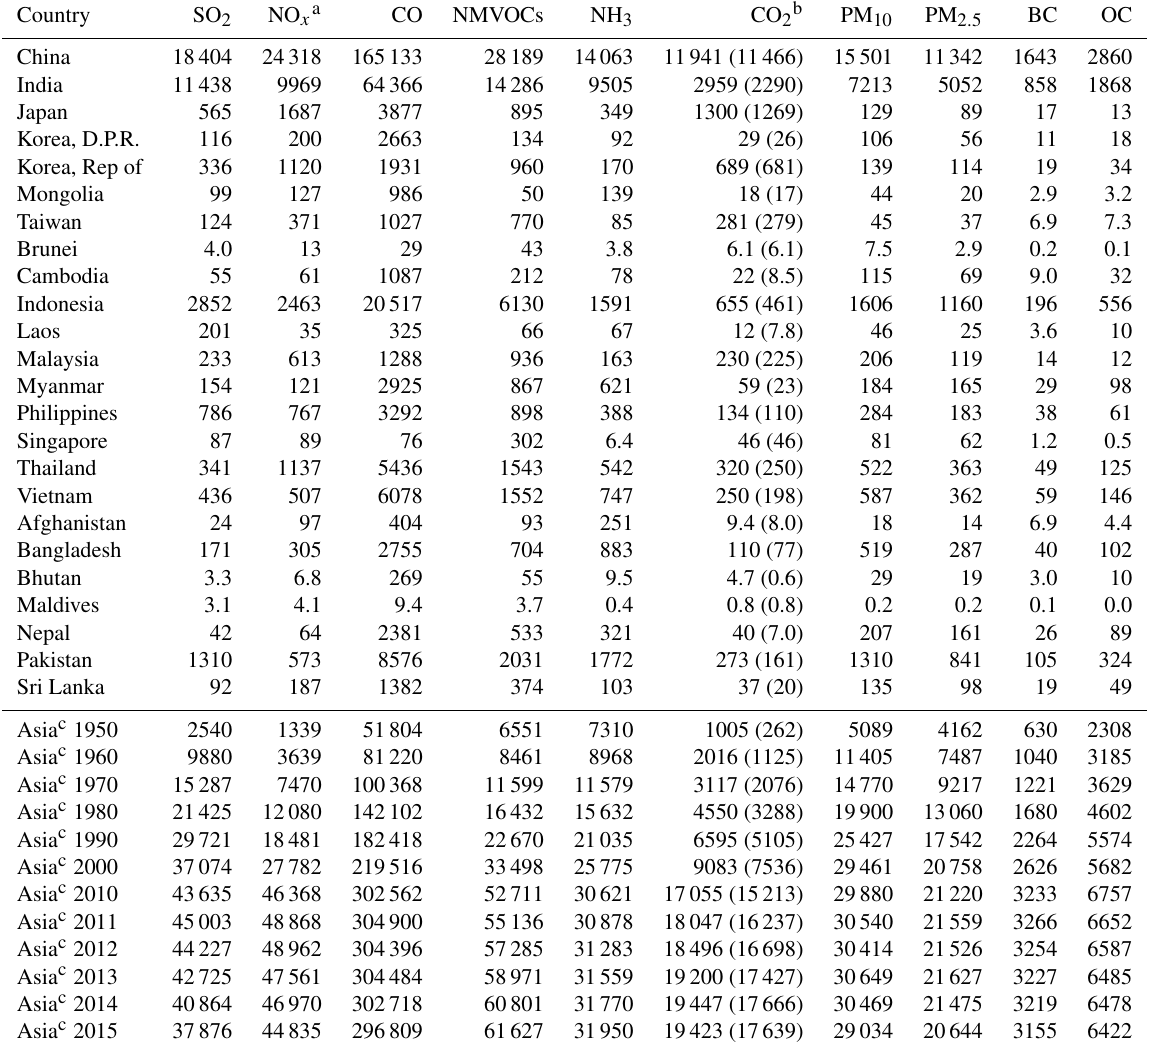
Table 3. Summary of national emissions in 2015 for each species and total annual emissions in Asia in 1950, 1960, 1970, 1980, 1990, 2000, and 2010–2015 (Ggyr − 1